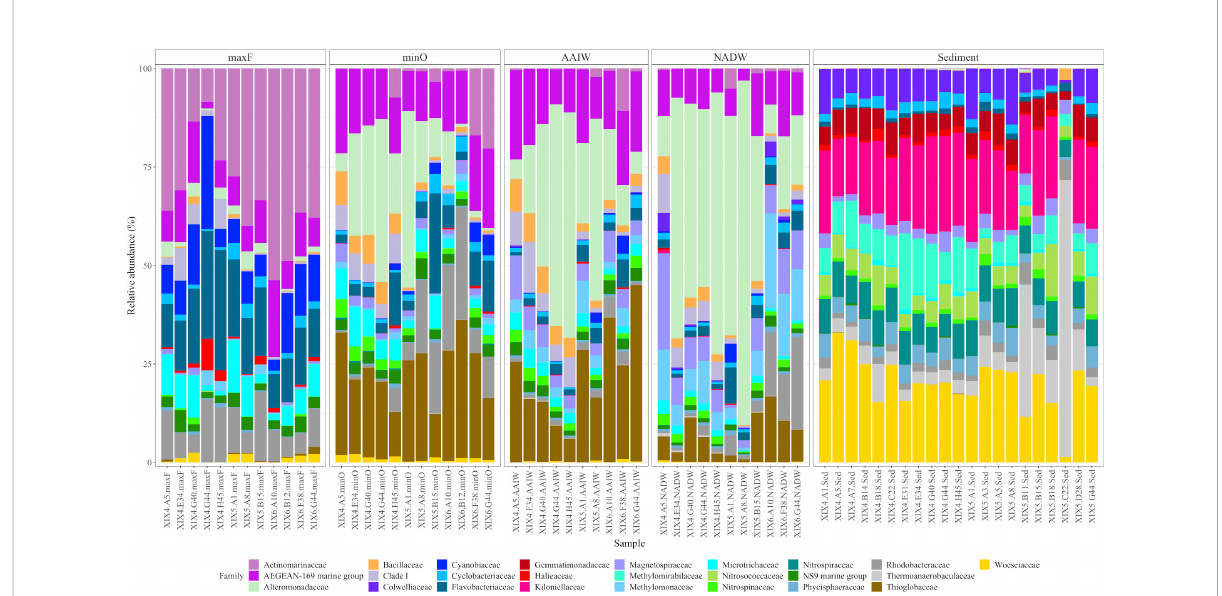
FIGURE 4 Taxonomic composition and relative abundance of the 25 most abundant families, based on the16S rRNA analysis. Labels on the bottom indicate cruise, sample, and water mass (ex: